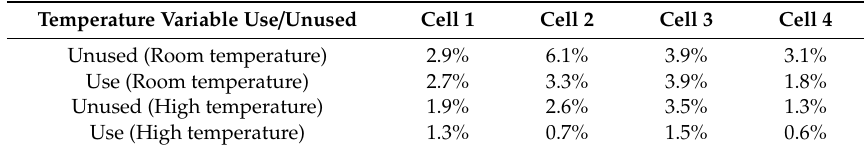
Table 5. Comparison of the SOC estimation results using the LSTM of Cell 1 to Cell 4 according to the temperature variable.